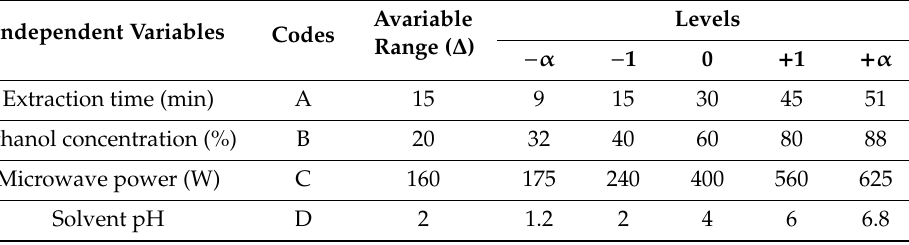
Table 1. Independent variables and their corresponding levels.